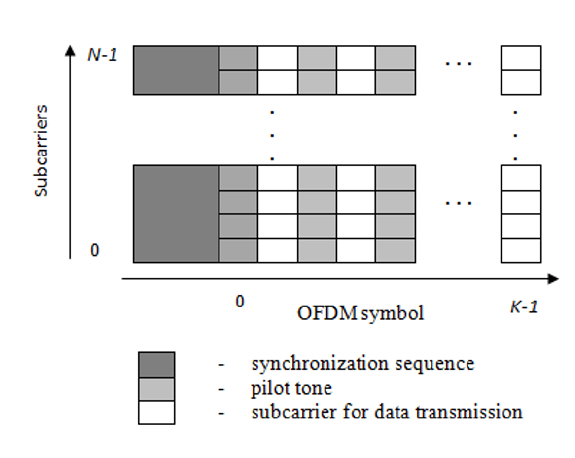
Figure 1. Pilot tones pattern